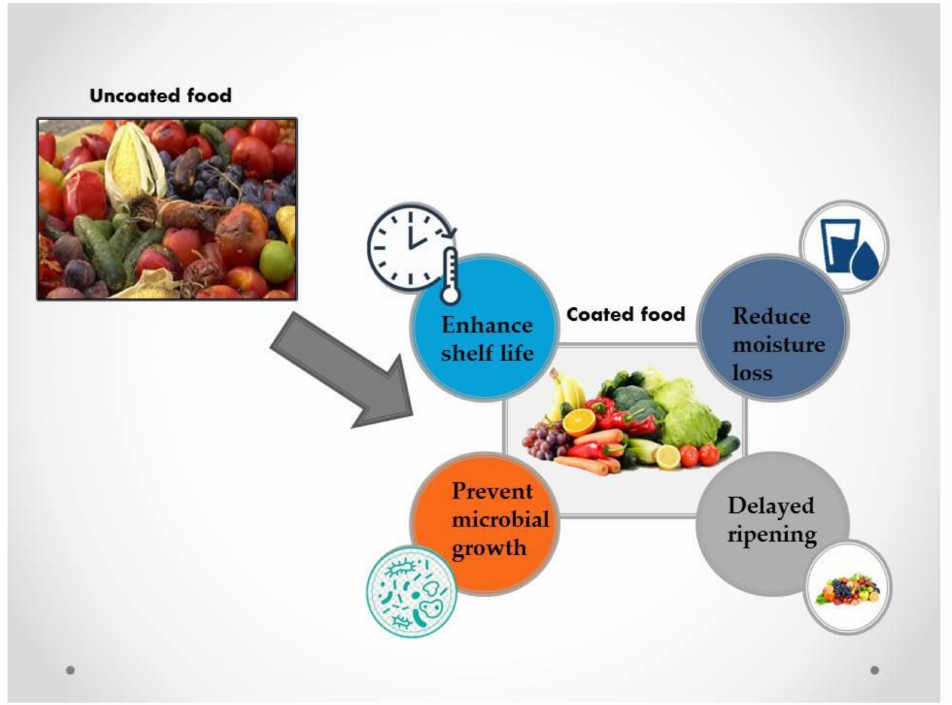
Figure 3. Beneficial effects of spraying on fruits and